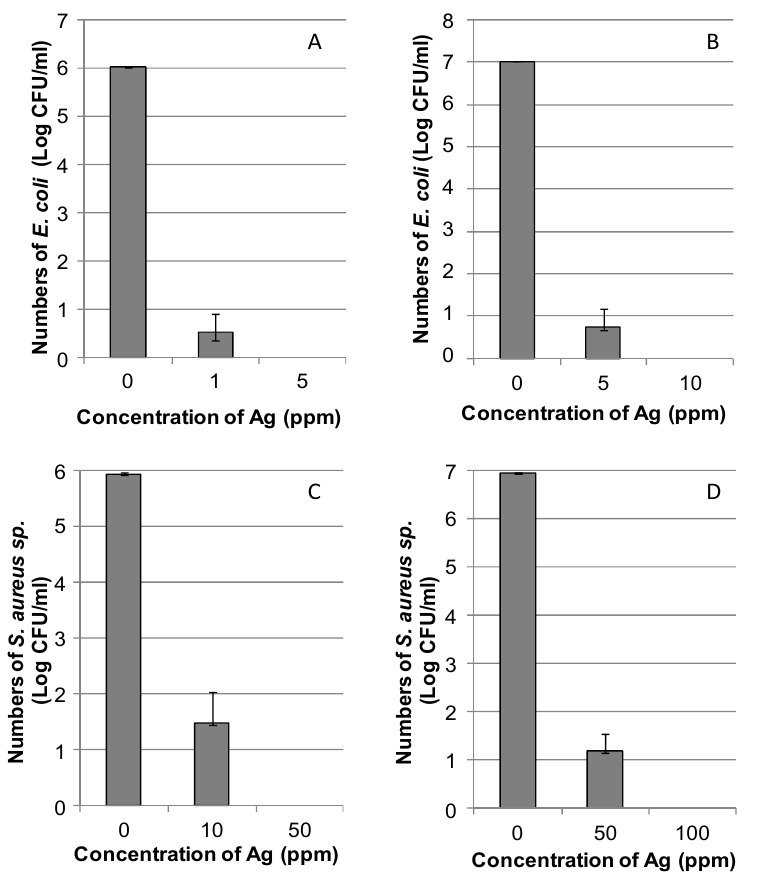
Figure 3. Number of colonies after incubation with a DNA/Ag nanoparticle aqueous suspension at different concentrations. ( A ) 1.04 × 10 6 colony-forming units (CFU)/mL; ( B ) 1.04 × 10 7 CFU/mL, of E. coli ; ( C ) 8.65 × 10 5 CFU/mL; ( D ) 8.65 × 10 6 CFU/mL, of S. aureus were applied (without DNA/Ag nanoparticles, n = 2; with DNA/Ag nanoparticles, n =